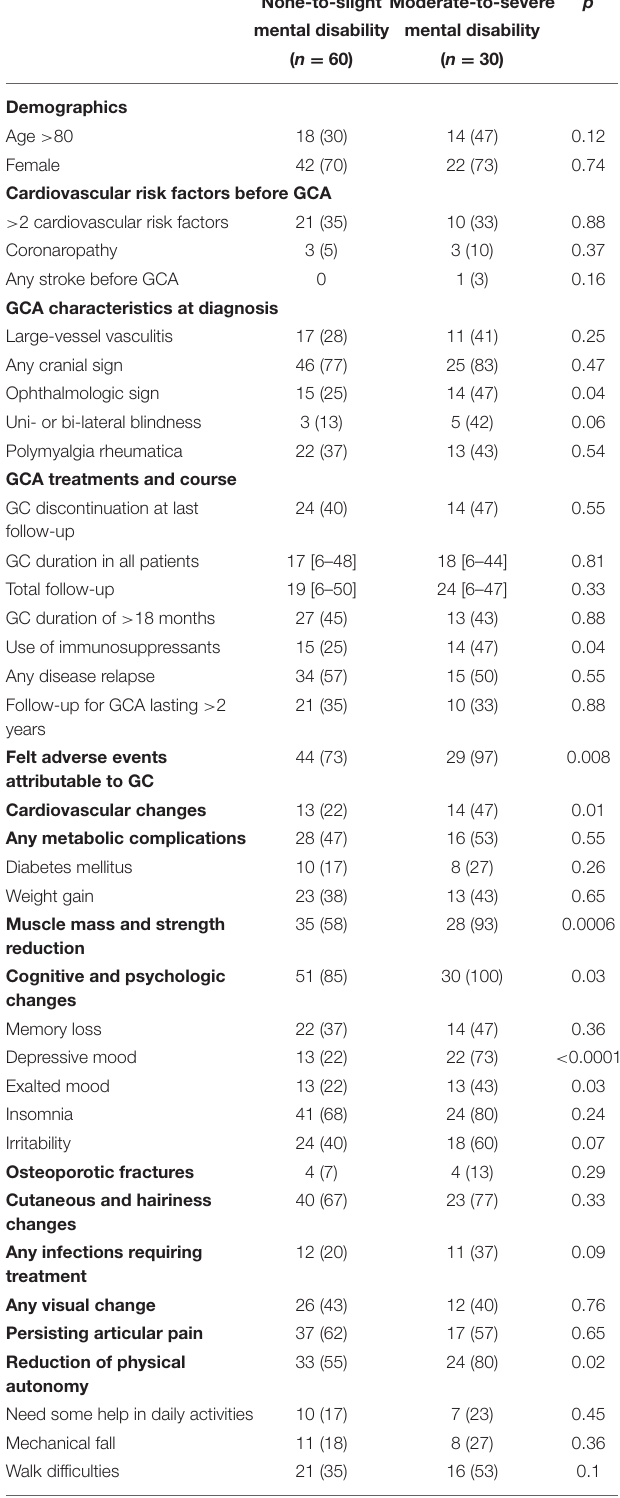
TABLE 2 | Factors associated with moderate-to-severe physical disability in univariate and multivariate models. Univariate OR, P Multivariate OR,